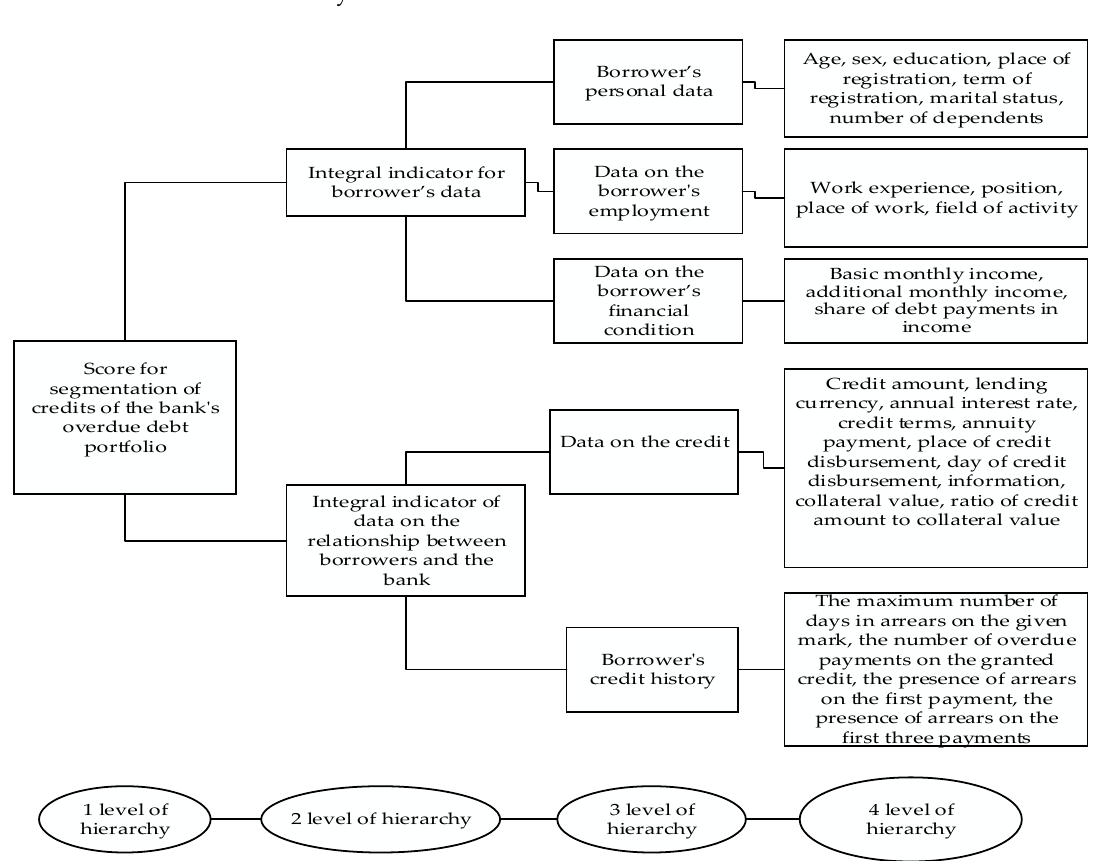
Figure 1. Hierarchy tree of the economic-mathematical model of risk assessment of credits of a bank’s overdue debt portfolio by the segment of lending to individuals (author development).